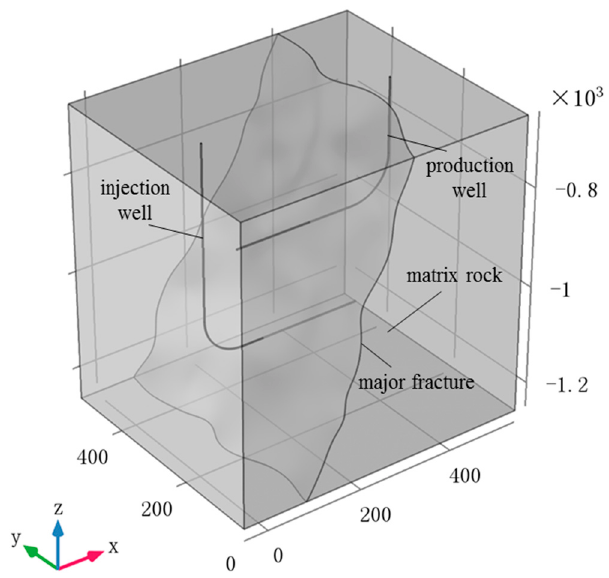
Figure 1. Ideal dual horizontal well EGS exploitation model (unit: m).